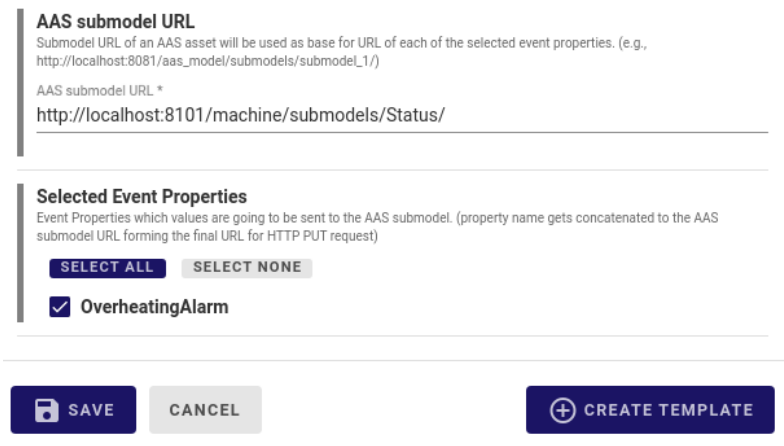
Figure 8. Configuration dialog of the DT Sink.